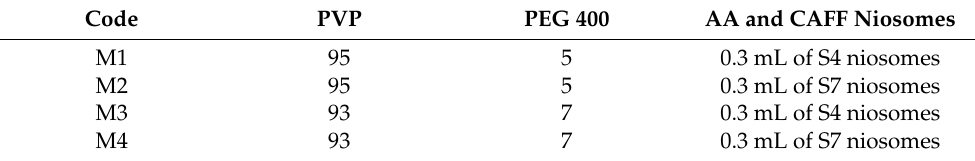
Table 2. Composition of AA and CAFF niosomal nanoparticles in